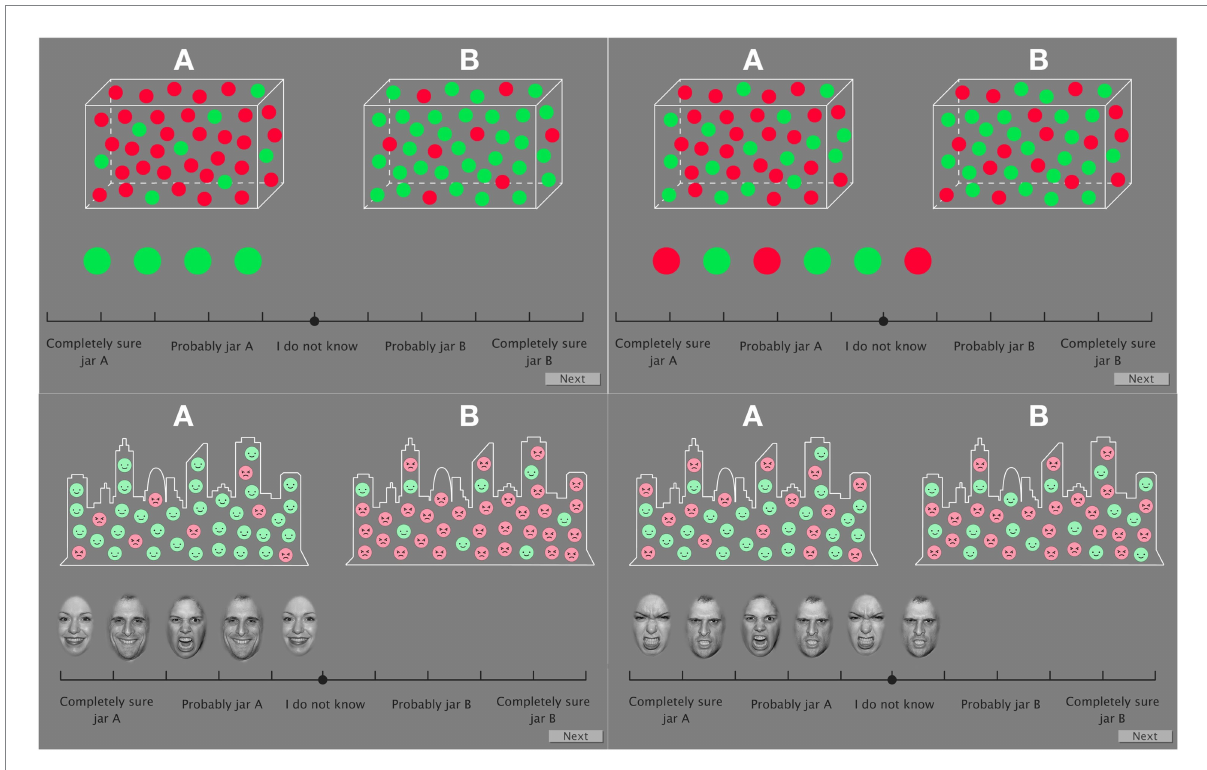
FIGURE 1 An example of four different trials of the Beads task with neutral (top row) and emotional (lower row) content. Left screenshots show trials corresponding to the 80:20 jar ratio. Specifically, in the top left example, Series 5 (0Red:100Green) is represented; in the bottom left example Series 6 (80Happy:20Angry) is presented. Right pictures show trials of the 60:40 jar ratio. Specifically, top right picture presents Series 1 for beads (60Red:40Green) and Series 5 (0Happy:100Angry) for faces on bottom right side. Images used with permission from Tottenham et al.